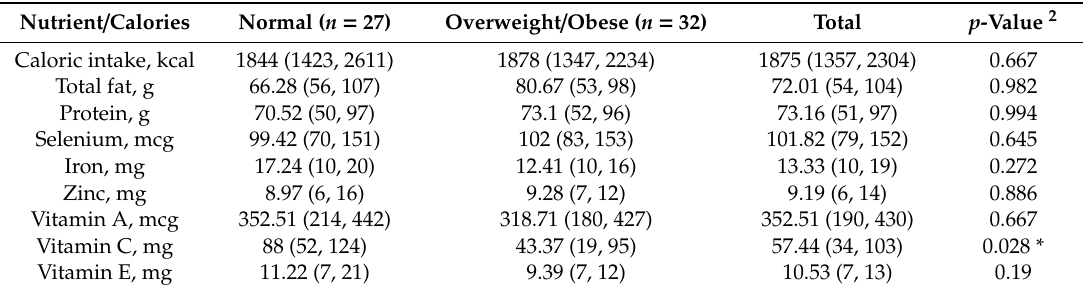
Table 1. Daily nutrient intakes among young adults with normal weight or overweight / obesity 1 .